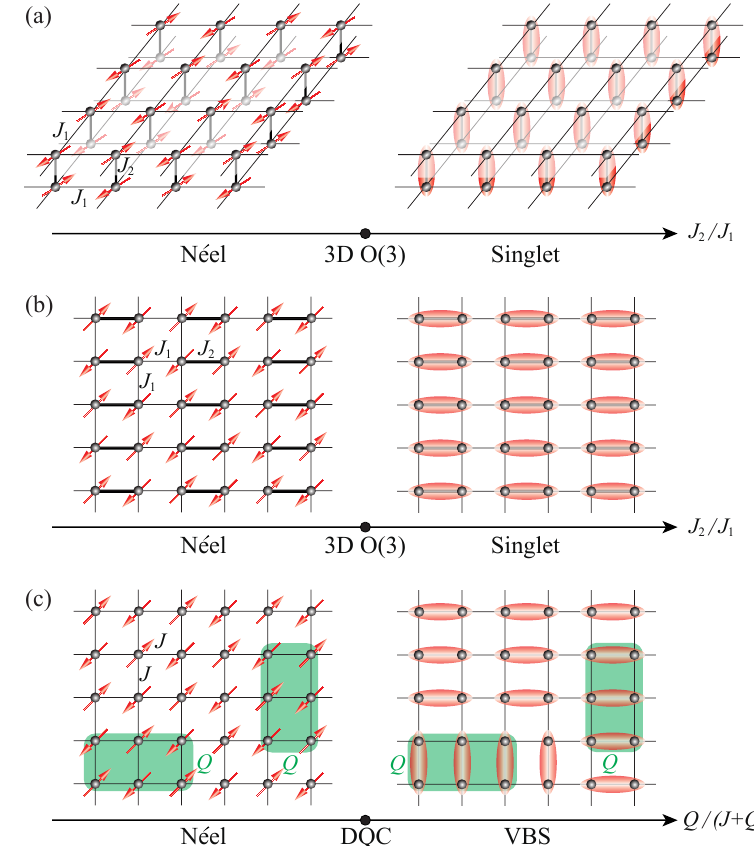
Figure 1: The three lattice models: (a) the bilayer square lattice antiferromagnetic Heisenberg model, (b) the square lattice J and (c) the J - Q model. (a), (b) exhibits ( 2 + 1 ) d O(3) QCP as J 3 and (c) gives rise to DQC [ 4 ]